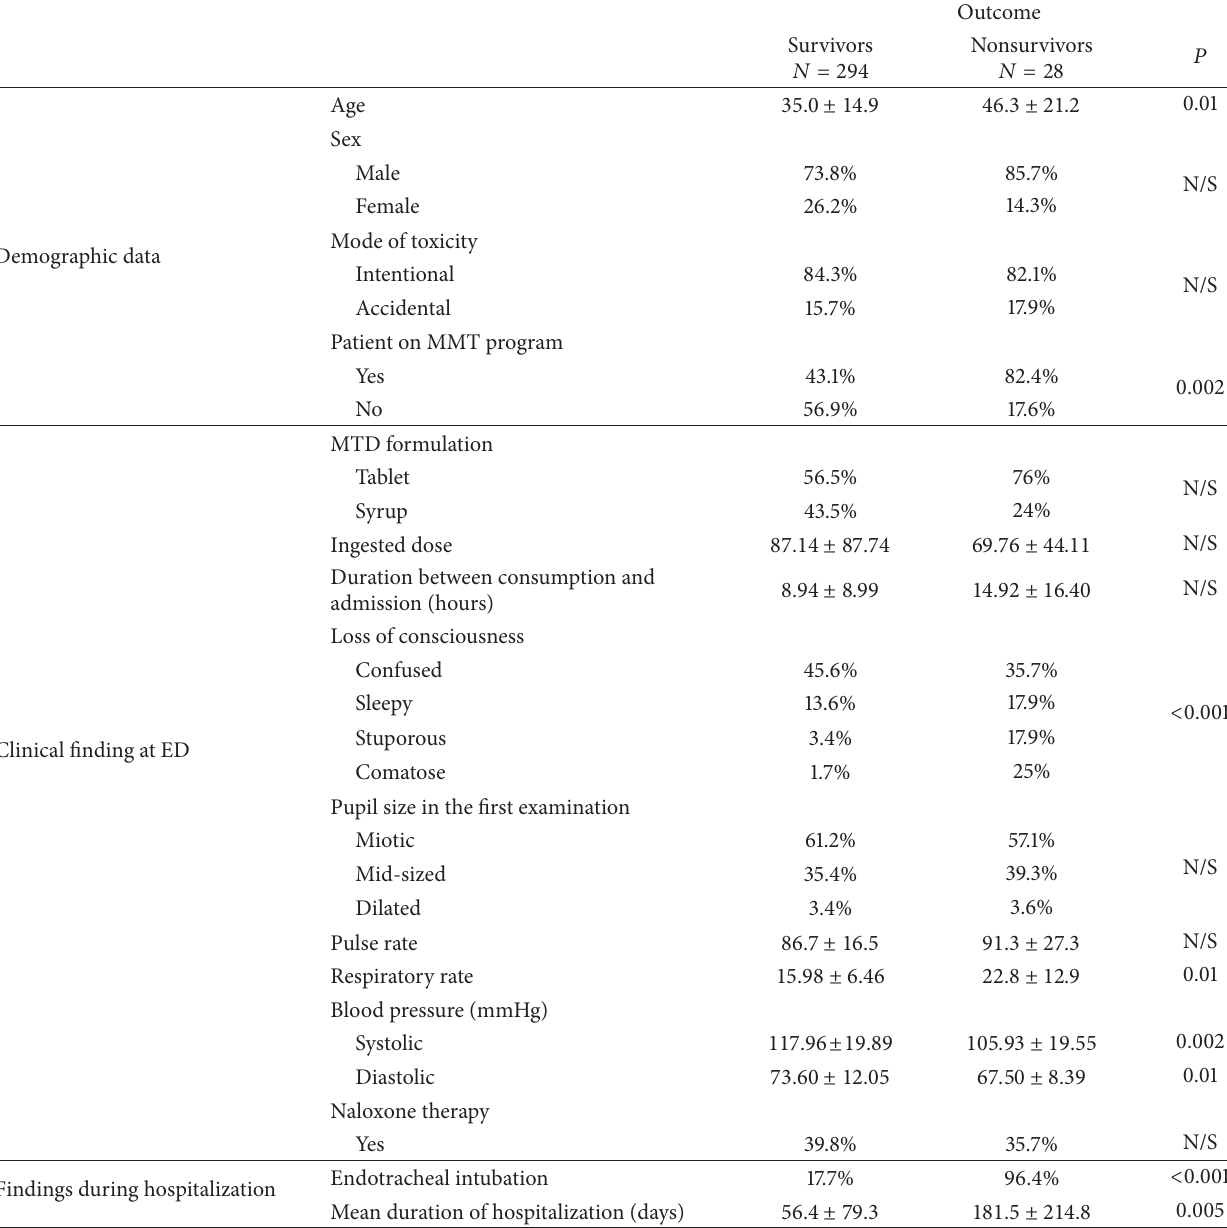
Table 1: Comparison of demographic data and clinical findings between survivors and